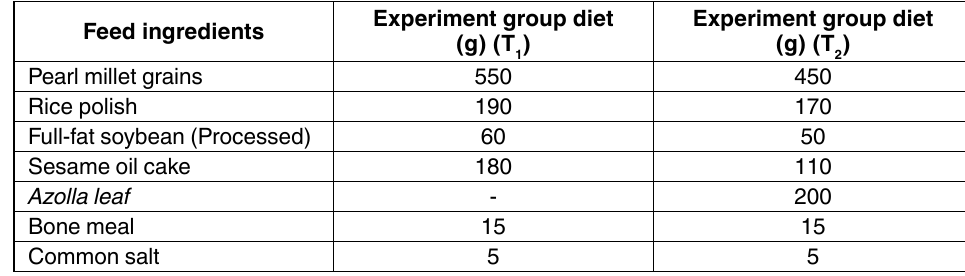
table1. Composition of experimental diets Feed